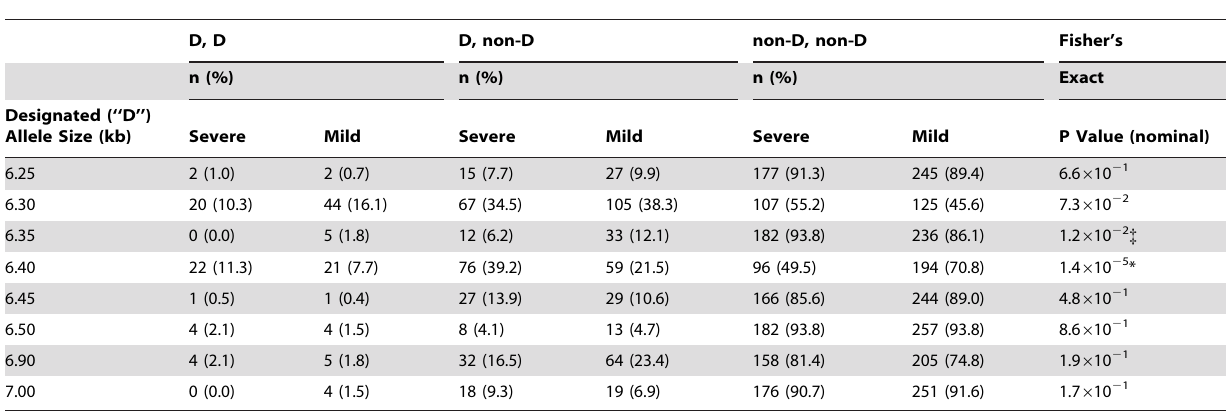
D, D D, non-D non-D, non-D Fisher’s n (%) n (%) n (%)